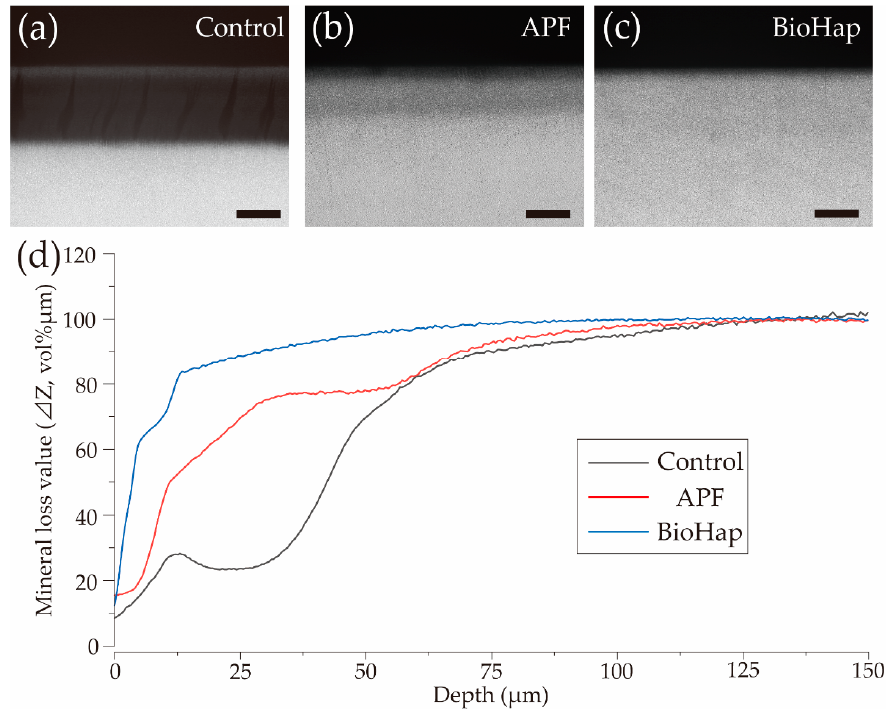
Figure 6. Contact microradiography (CMR) images of enamel cross-sections after acid challenge. CMR cross-sectional images of the reference and experimental surfaces after acid challenge in the ( a ) control, ( b ) APF, and ( c ) BioHap groups. Scale bar is 50 µm. ( d ) Graphical representation of mineral loss value ( ∆ Z) by tooth depth. Black, red, and blue lines represent the control, APF, and BioHap groups, respectively.